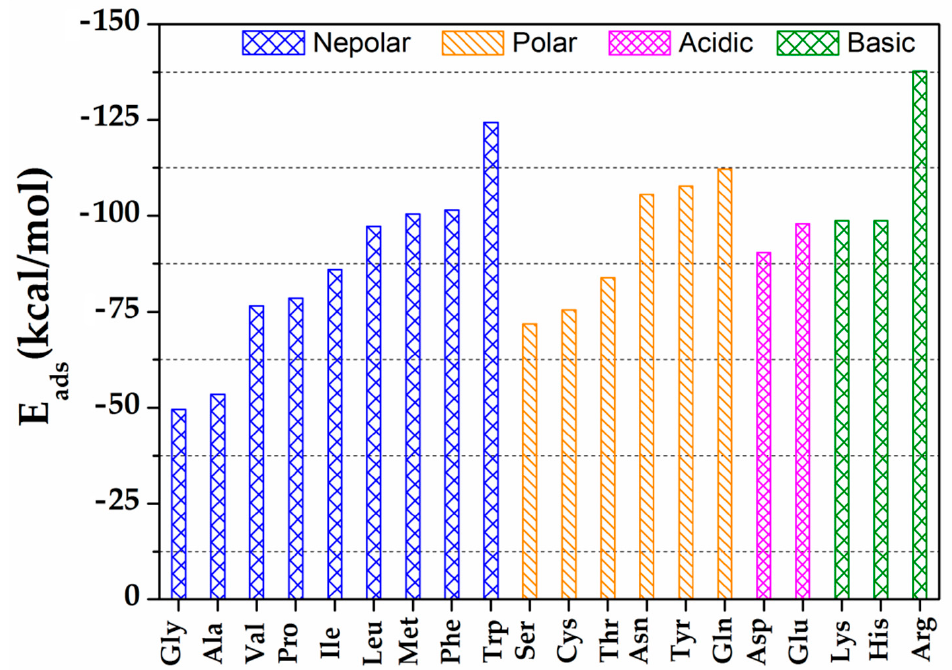
Figure 5. The adsorption energy (E ads ) obtained from the Monte Carlo simulations of L-amino acids on the Fe (100) surface in gas phase.